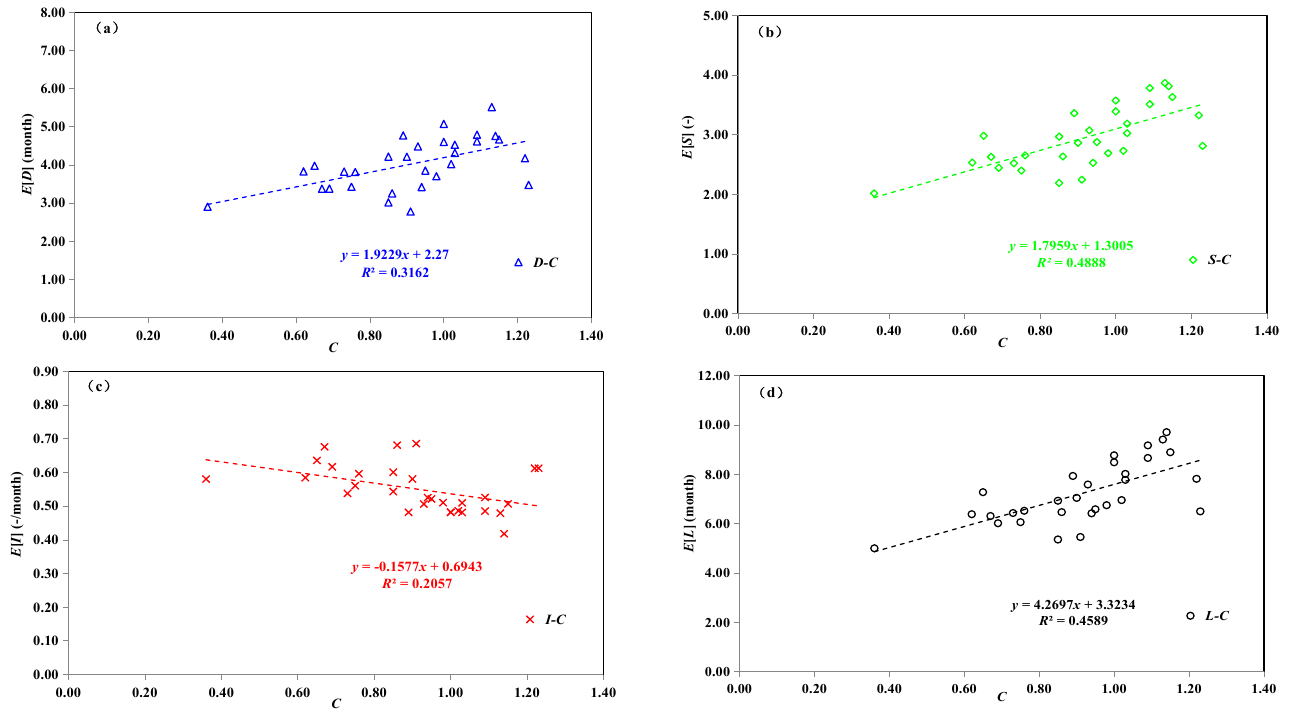
Figure 7. Correlation between C and ( a ) E [ D ]; ( b ) E [ S ]; ( c ) E [ I ]; ( d ) E [ L ].